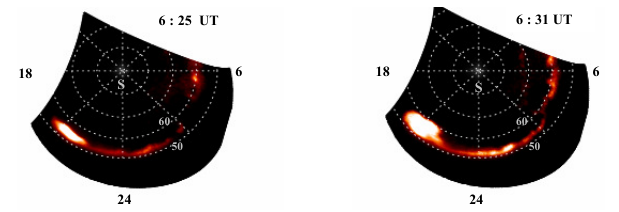
Fig. 2. Two consecutive WIC images made in the night sector of the Southern Hemisphere on 8 November. Distribution of the emission intensity is represented in MLT/magnetic latitude